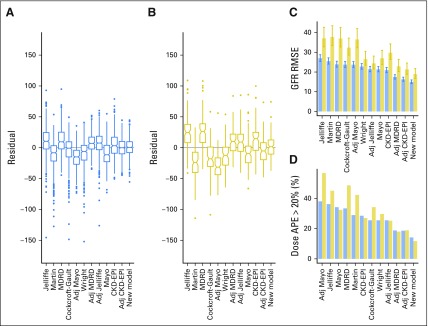
Graphical illustrations of statistics used to compare the new model and published models. Box plots of the residuals (measured glomerular filtration rate [GFR] minus estimated GFR) for all published models and the new model using (A) the internal validation data set and (B) the external validation data set are shown. Notches delineate an approximate 95% CI for the median residual, calculated as ± 1.58*interquartile range/n0.5. A positive or negative value for the median residual indicates underestimation or overestimation bias, respectively. (C) Graphical illustration of GFR root-mean-squared error (RMSE) in the internal and external validation data sets. Error bars describe the 95% CI on the basis of the χ2 distribution for the calculated RMSE. (D) Graphical illustration of percentage of patients with a carboplatin dosing absolute percentage error (APE) > 20% in the internal and external validation data sets. For all plots, blue represents the internal validation set and gold represents the external validation data set. Adj, adjusted; CKD-EPI, chronic kidney disease epidemiology; MDRD, Modification of Diet in Renal Disease.